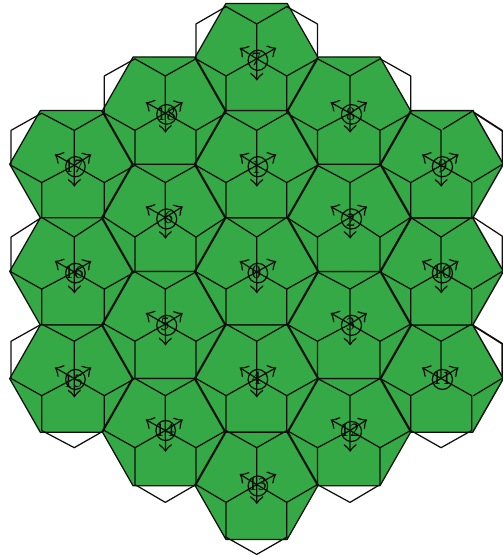
Figure 2: The cellular network of the downlink